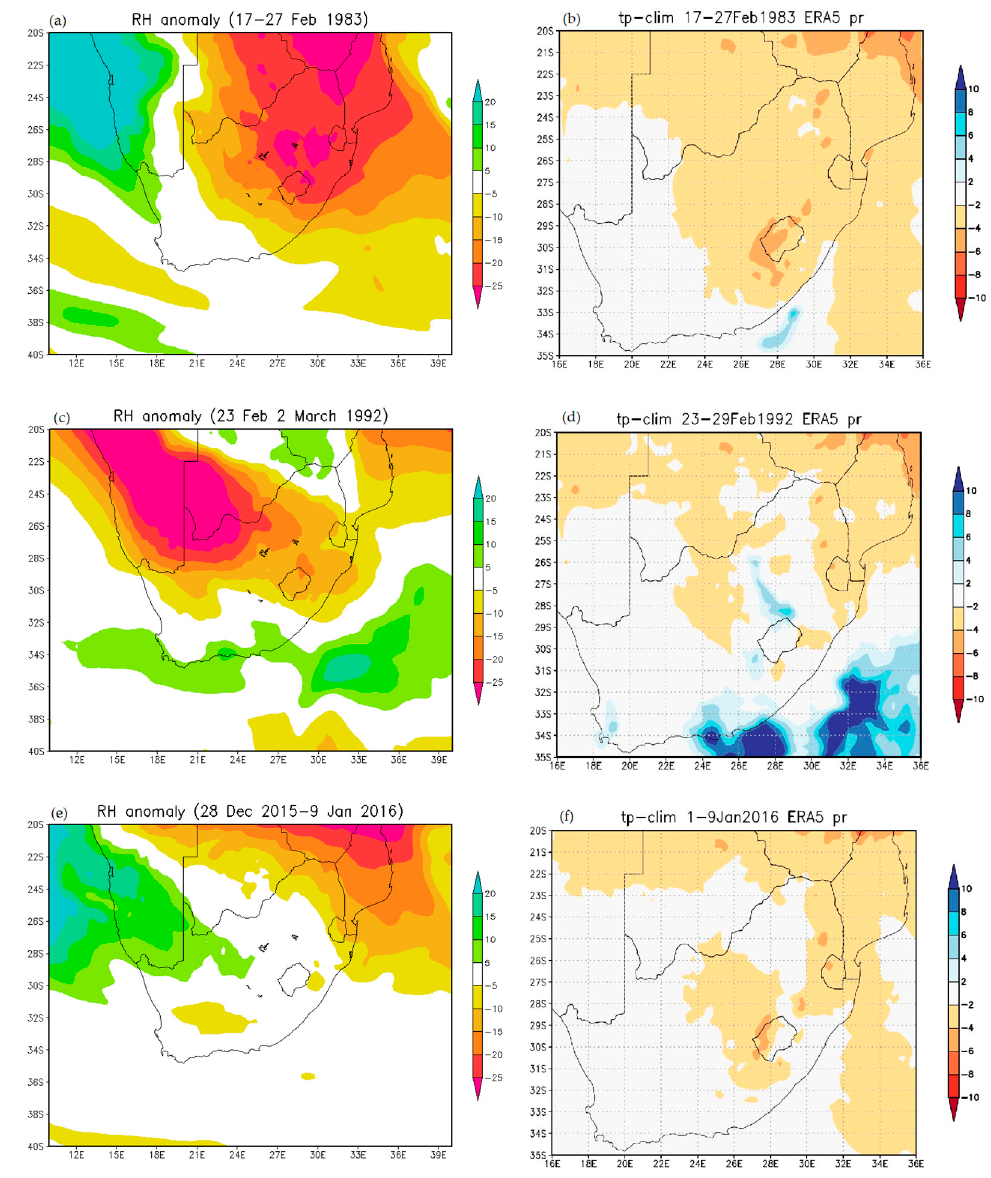
Figure 12. Relative humidity (RH) anomalies (%) at 500 hPa for the ( a ) 17–27 February (Feb) 1983 HW, ( b ) 23 February (Feb) 1991 to 2 March 1992 HW, and ( c ) 28 December (Dec) 2015–9 January (Jan) 2016 HW; and precipitation anomalies (mm) for the ( d ) 17–27 February (Feb) 1983 HW, ( e ) 1991 to 2 March 1992 HW, and ( f ) 28 December (Dec) 2015–9 January (Jan) 2016 HW.